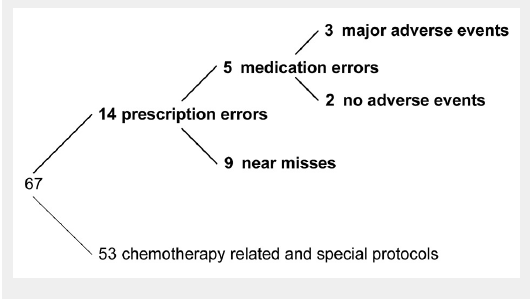
Analysis of the 67 cases with methotrexate administration intervals shorter than a week at the University Hospital,